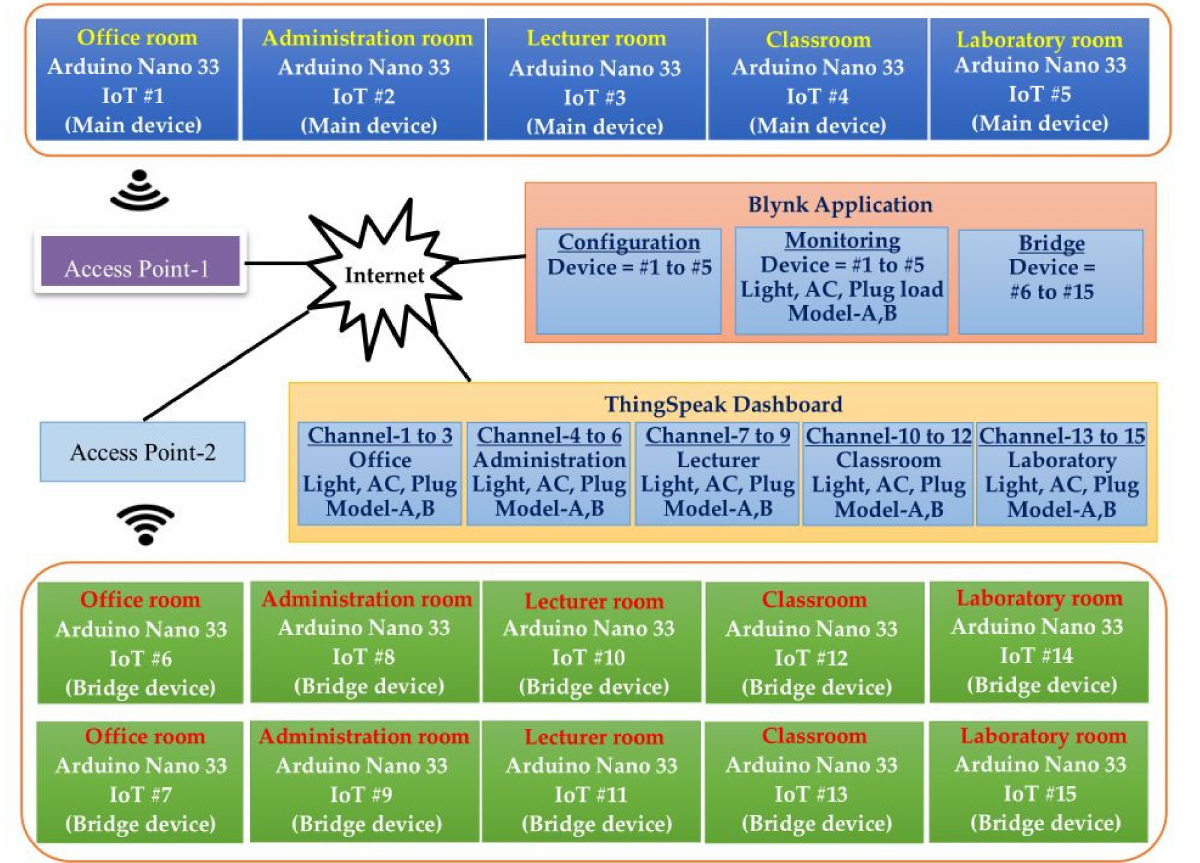
Figure 5. IoT system configuration.